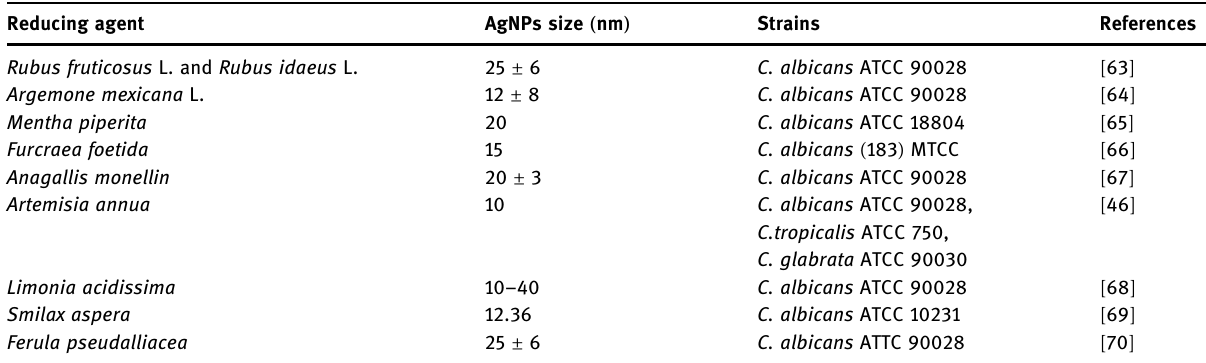
Table 3: Green synthesized AgNPs against di ff erent C. albicans strains